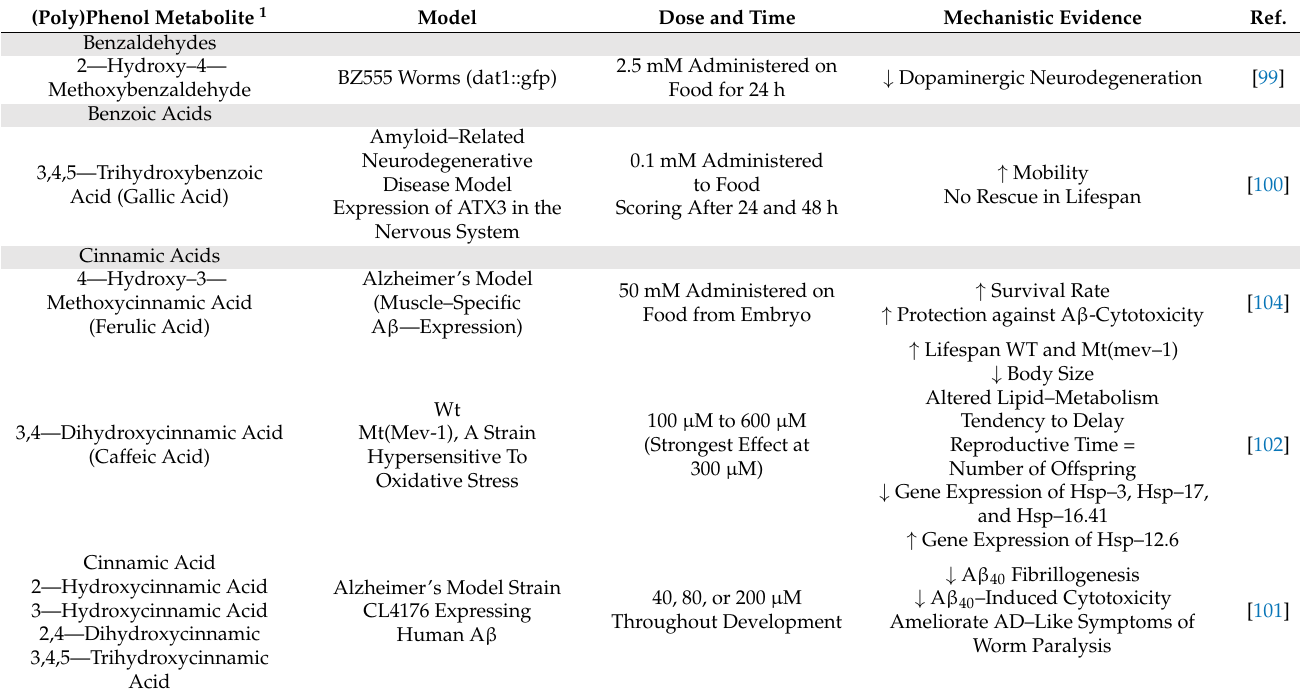
Table 3. Effects of low molecular weight (poly)phenol metabolites on models of neurodegeneration in C. elegans. (Poly)Phenol Metabolite 1 Model Dose and